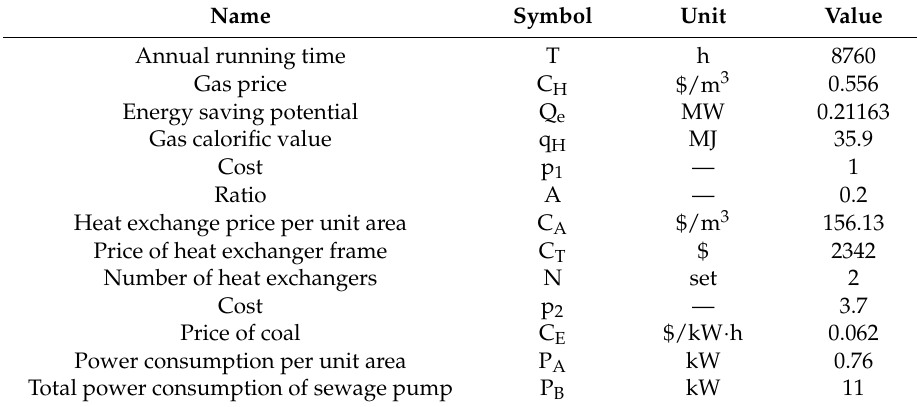
Table 3. Basic parameters.